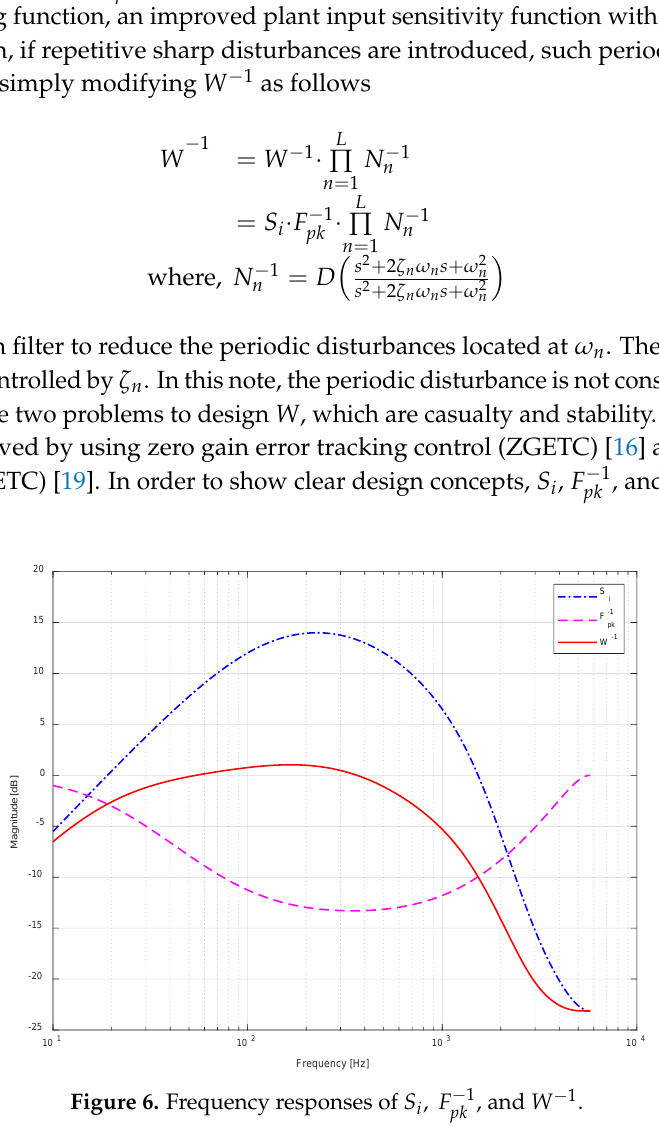
Figure 6. Frequency responses of S i , F